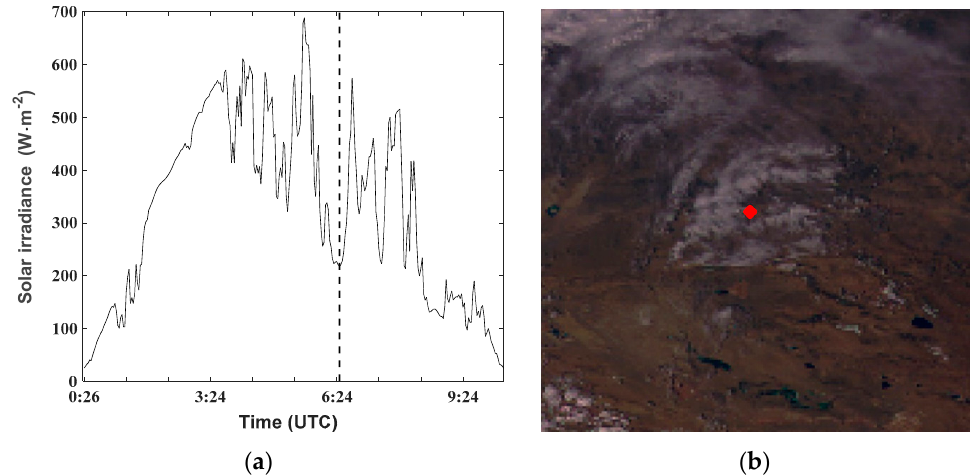
Figure 1. Example of ( a ) the diurnal variation of global horizontal solar irradiance (GHI) observed at the Dunhuang Gobi station on 1 November 2018 UTC and ( b ) the FY-4A satellite image on 1 November, 2018 at 06:30 UTC (the red point is the location of the Dunhuang Gobi station).